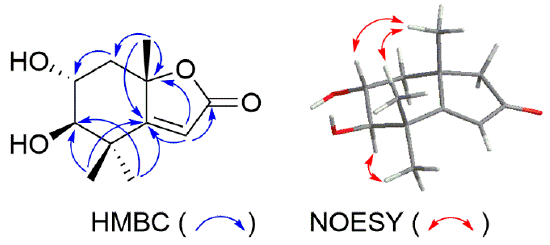
Figure 2. Selected HMBC and NOESY correlations of compound 11 .